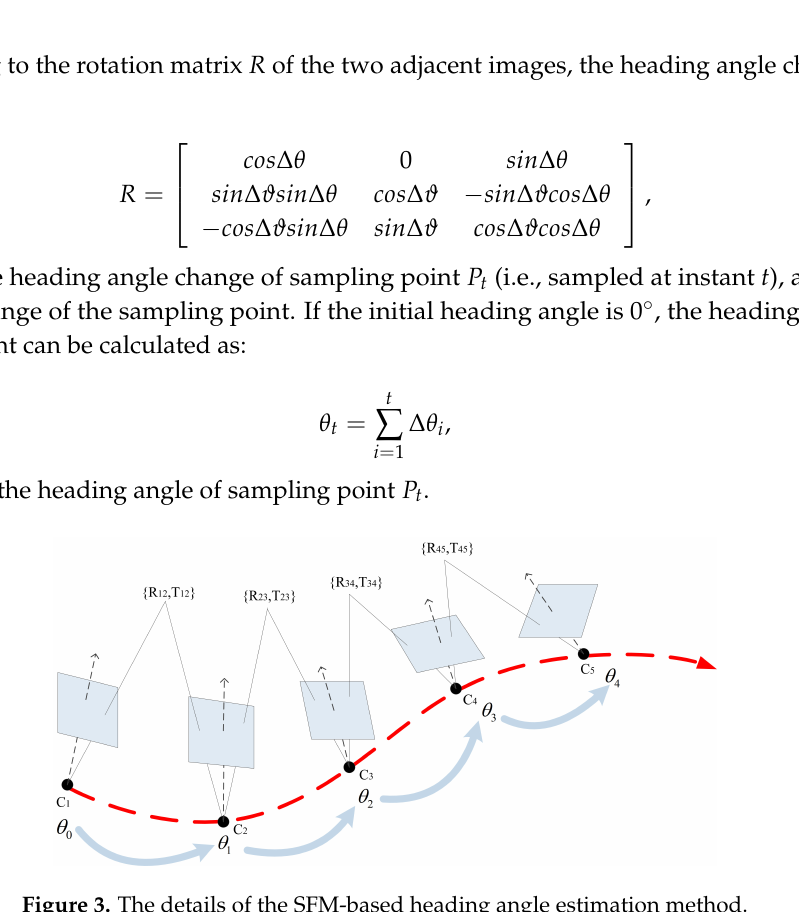
Figure 3. The details of the SFM-based heading angle estimation